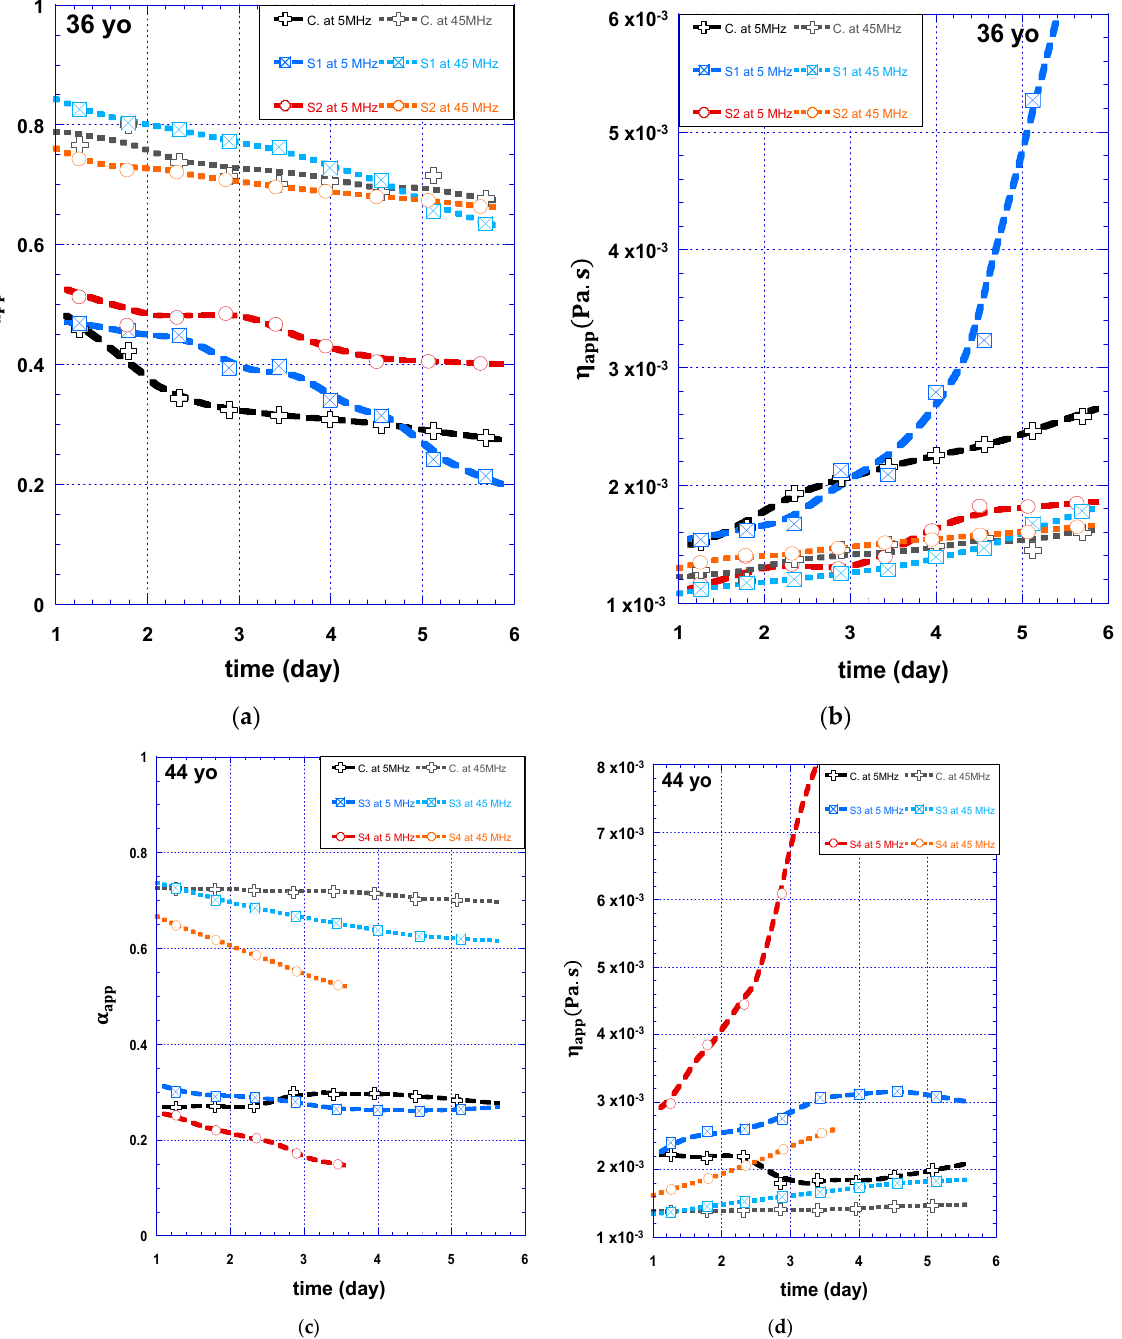
Figure 7. Shear mechanical kinetics of stripped skin explants: ( a ) changes in apparent structural parameter for the 36-year-old donor; ( b ) changes in apparent viscosity for the 36-year-old donor; ( c ) changes in apparent structural parameter for the 44-year-old donor; ( d ) changes in apparent viscosity for the 44-year-old donor. S1, S2 and S3, S4 are 5 times stripped living skin explants. The original skin is noted control “C.”.